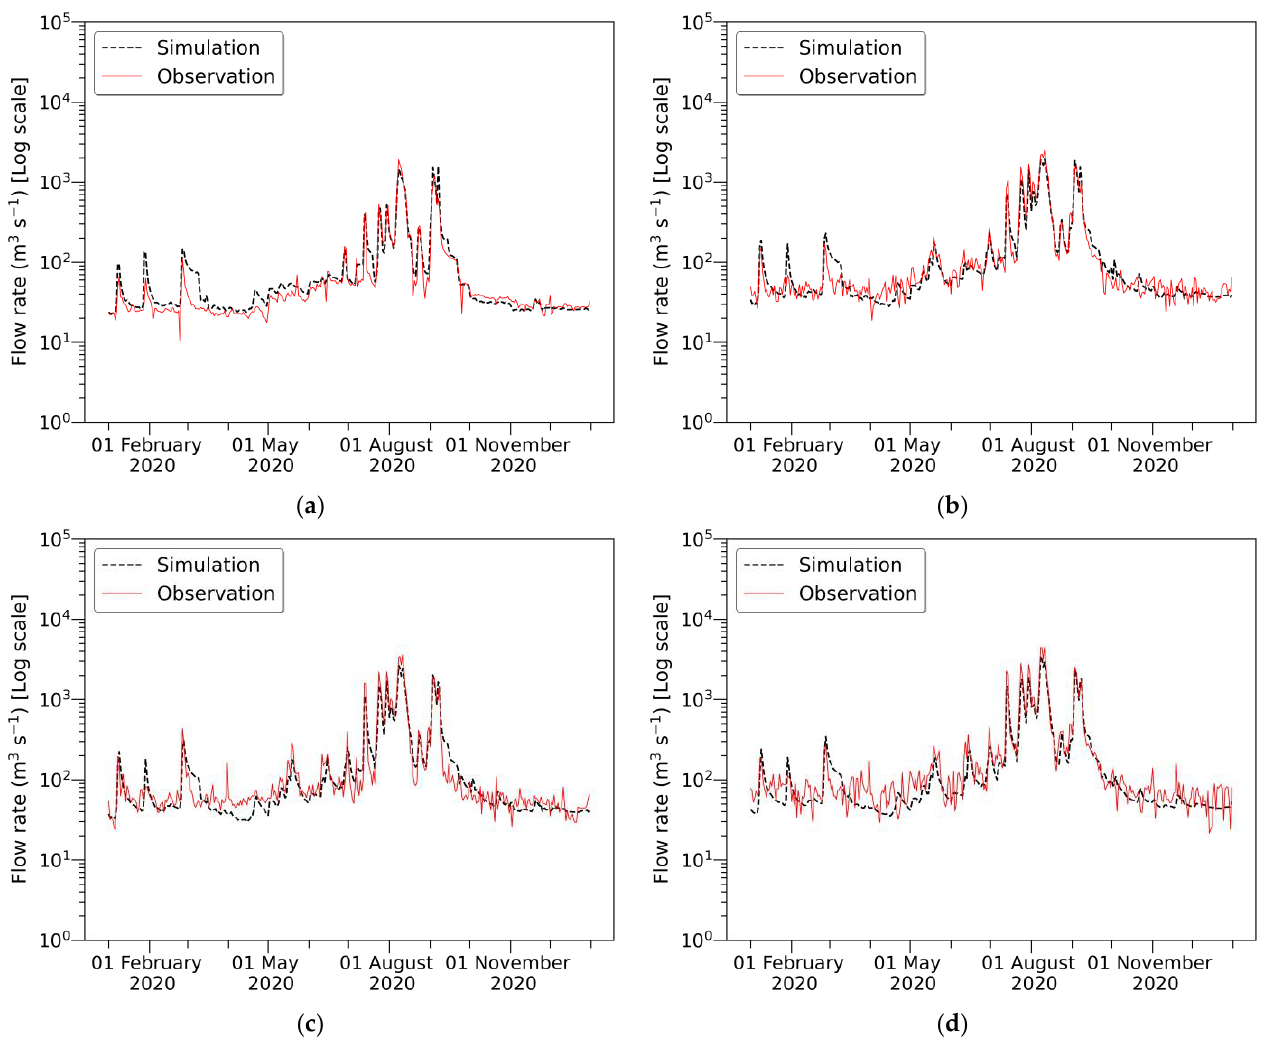
Figure 5. Hydrographs showing the difference between simulation and observation for validation.